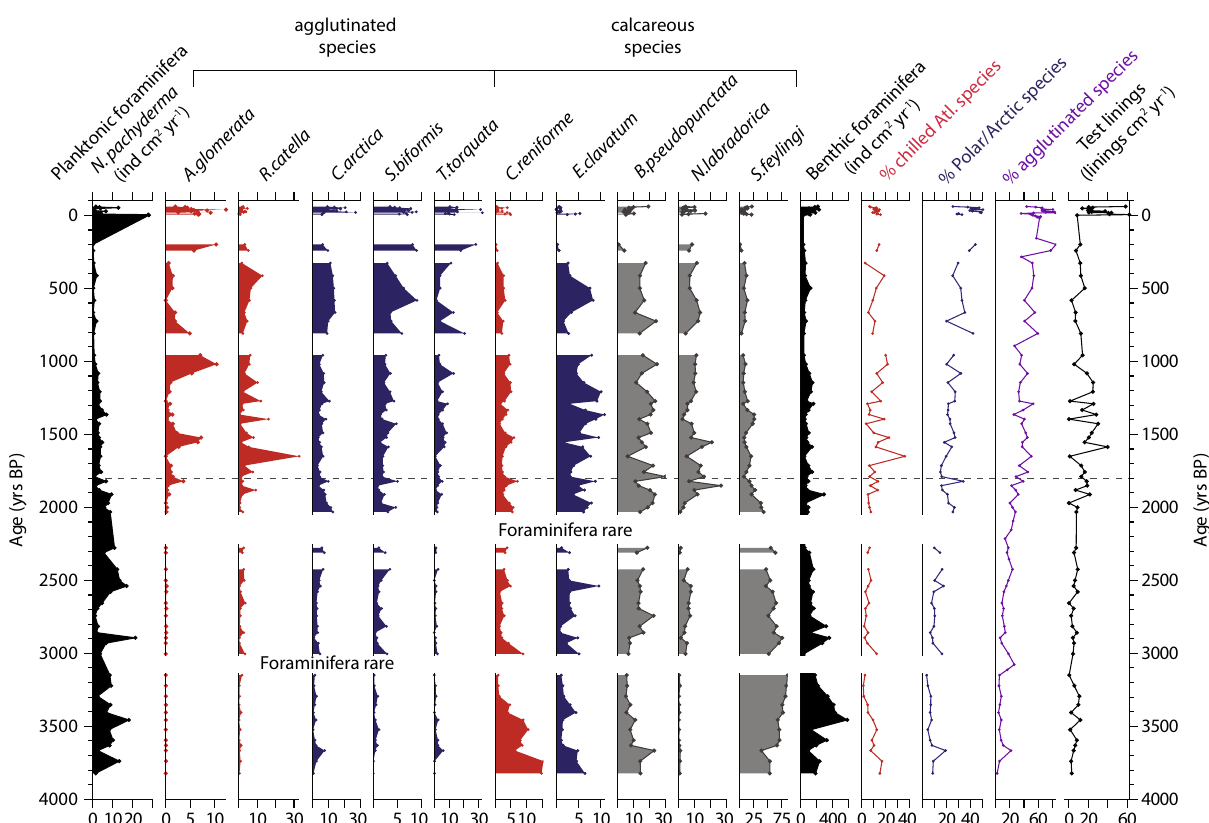
Figure 6. Foraminifera fluxes and assemblages in CASQ1 and CASQ1 BC. Planktonic foraminifera ( N. pachyderma sin.) fluxes are shown in black. Benthic foraminifera assemblages are show as percentage of the entire assemblage and colour coded according to Table 2. Only species that account for > 5% of the total assemblage in at least 1 sample are shown. Total benthic foraminifera fluxes (black) are shown as well as the overall (agglutinated and calcareous) % of chilled Atlantic water (red) and Polar/Arctic (blue) indicator species.